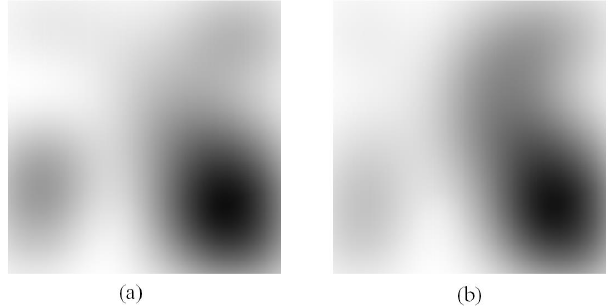
Figure 22. After converting the data into a grayscale image, the comparison between ( a ) normal sample and ( b ) abnormal sample. Table 14. Test results from CNN.